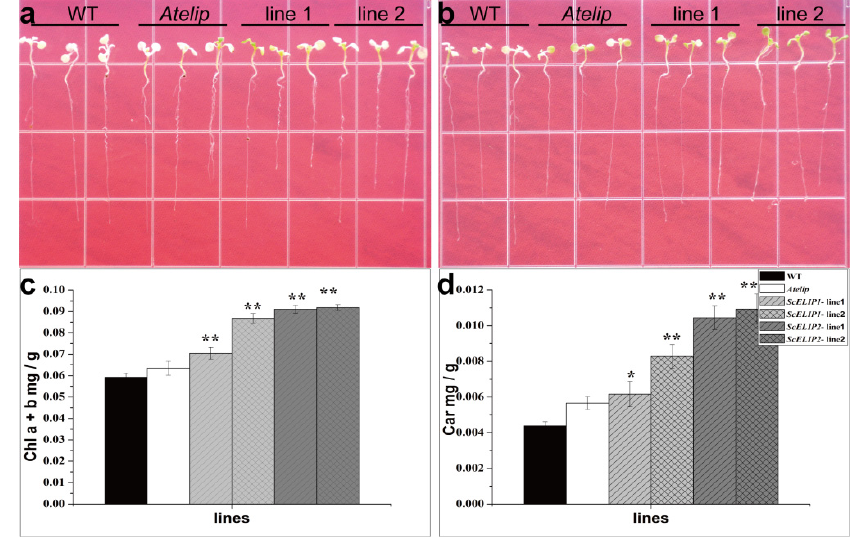
Figure 5. Phenotypic response of Col-0 WT, the Atelip mutant, and 35S-ScELIP1 and 35S-ScELIP2 transgenics to high-light irradiation (1500 µ mol / m2 / s) for 2 h and recovery for 24 h under control conditions. ( a ) Col-0 WT, Atelip, and 35S-ScELIP1 ; ( b ) Col-0 WT, Atelip, and 35S-ScELIP2 ; ( c ) Chlorophyll content of Col-0 WT, Atelip, and 35S-ScELIP transgenics after exposure to 2 h of high-light irradiation followed by 24 h of recovery in control conditions; ( d ) Carotenoid content of Col-0 WT, Atelip, and 35S-ScELIP transgenics after exposure to 2 h of high-light irradiation followed by 24 h of recovery in control conditions.